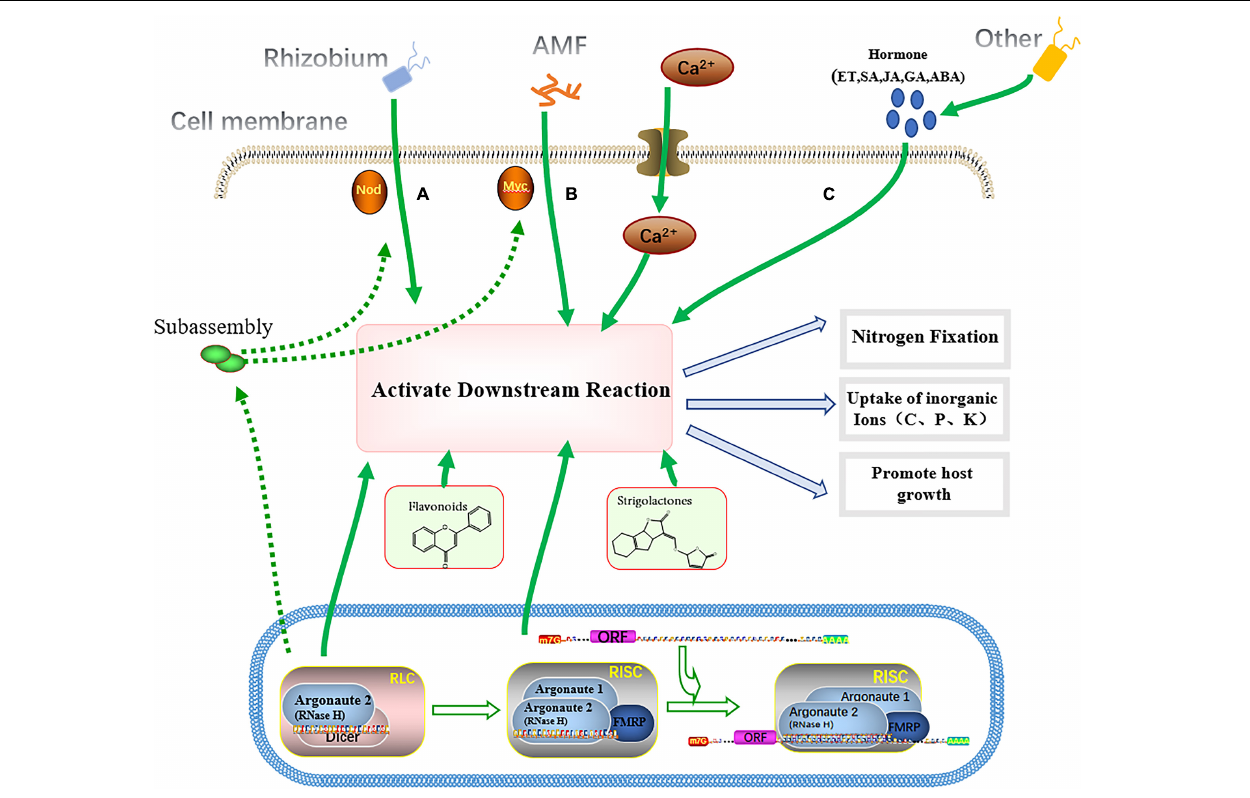
FIGURE 2 | Endophytes affect host growth. Endophytes release factors that act on host cells, which express RNA-induced silencing complex ( RISC ) genes and silence specific genes, thereby regulating the invasion process of endophytes. (A) Under the action of Nod factor, rhizobia formed root nodules and fixed N 2 . (B) AMF form clumped mycorrhizae (AM) under the action of Myc factors, which promote host uptake of inorganic ions (C, P, N, etc.) and regulate the root environment. (C) Some endophytes are able to produce hormones (SA, JA, GA, ET, ABA, etc.) that promote host